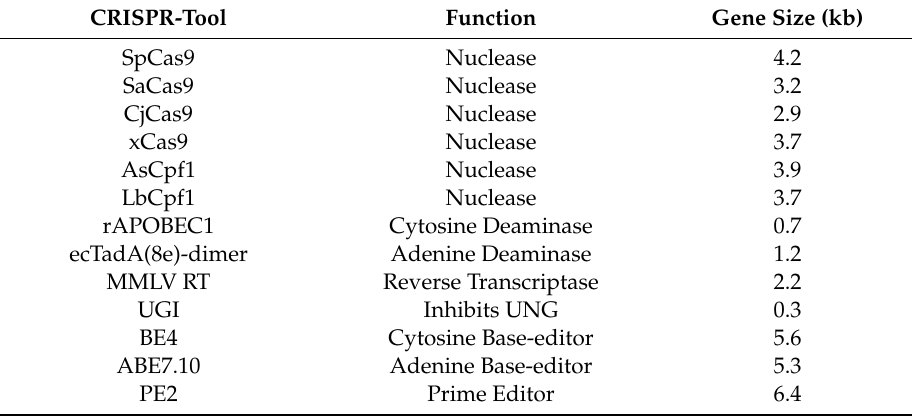
Table 2. Genetic Payload of Base-editing